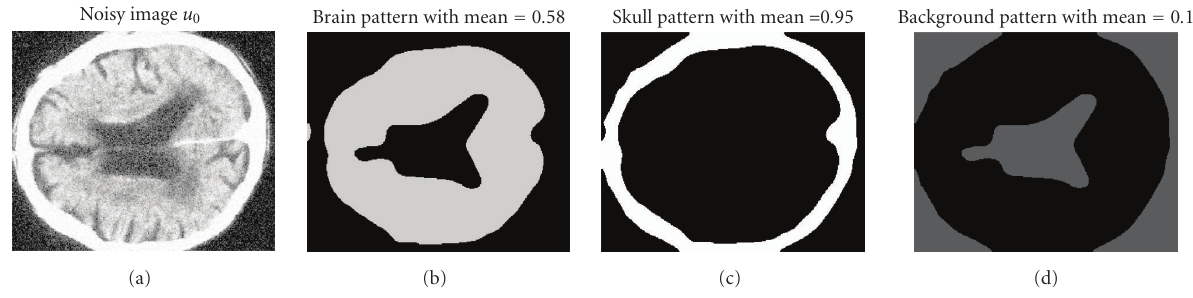
Figure 5: A real noisy brain image: hard segmentation from the SMS model via “hardening” formulae (5) and (6).